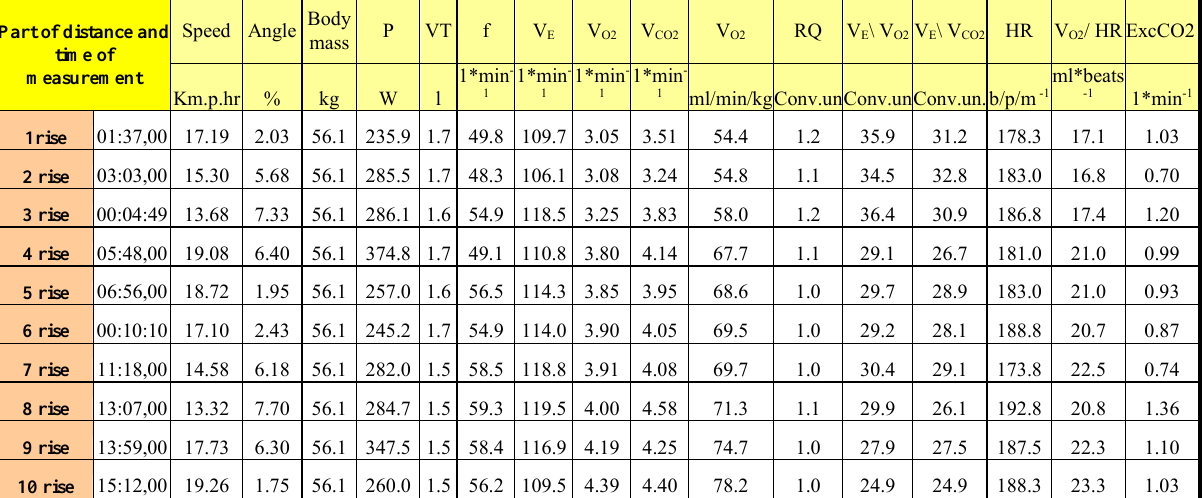
Indicators of female skiers’ functional fitness in conditions simulating passing of competition distance at the beginning of training period